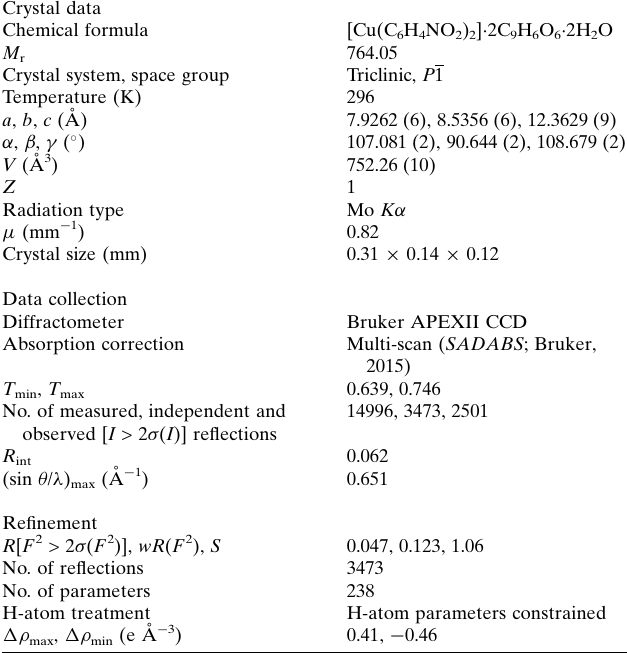
Table 2 Experimental details.